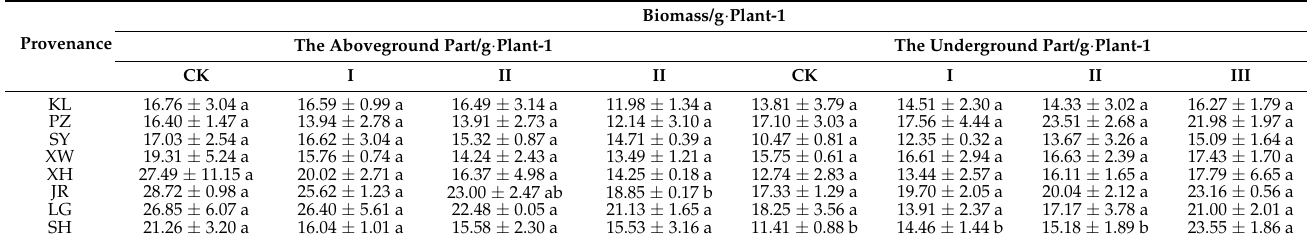
Table 4. The biomass distribution of the Melia azedarach seedlings among different provenances under drought stress.